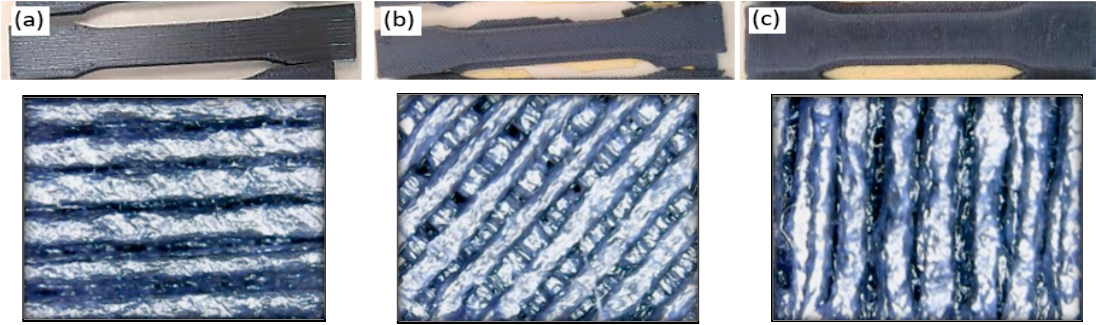
Figure 3. ( a ) Fiber orientation—0 ◦ ; ( b ) Fiber orientation—45 ◦ ; ( c ) Fiber orientation—90 ◦ .